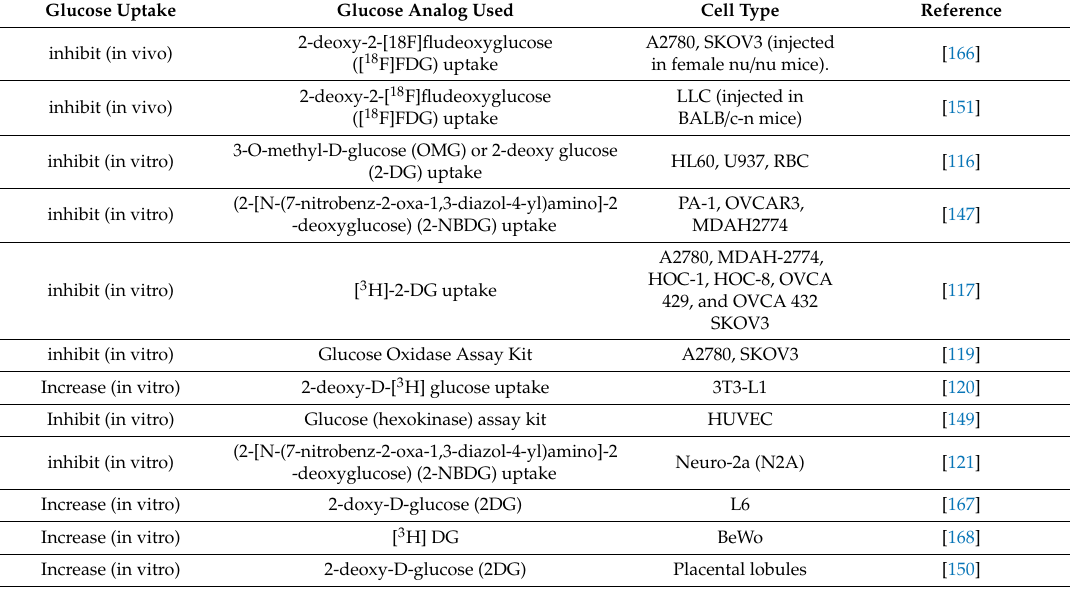
Table 2. Resveratrol and glucose